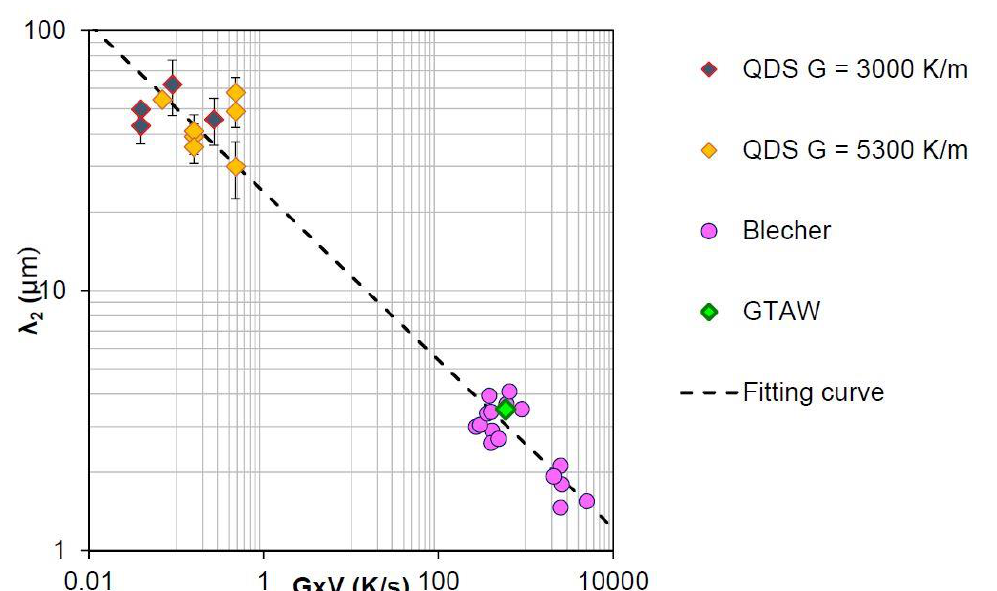
Figure 2. SDAS evolution of FM52 alloy as function of the cooling rate in K/s for QDS, GTAW experiments and Blecher et al.’s [45] measurements.